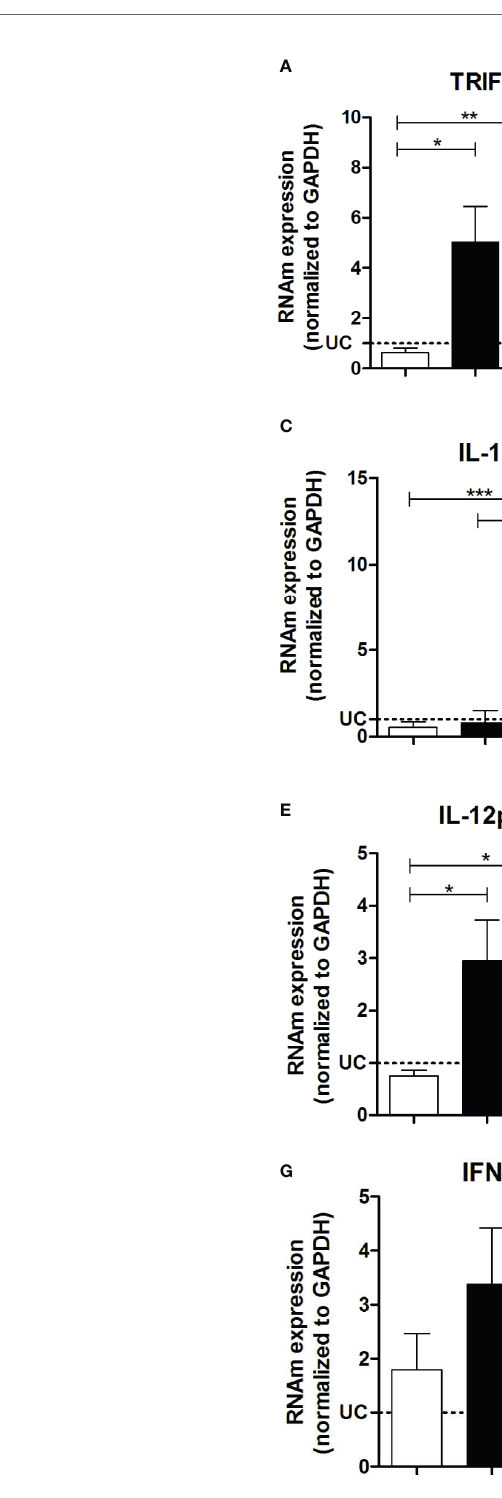
FIGURE 4 | Virulence of strains is correlated with TRIF, Myd88, IL-6, IL-12 inhibition in the heart from mice.The mRNA expression levels of TRIF (A) , Myd88 (B) , IL-10 (C) , IL-6 (D) , IL-12p35 (E) , IL-12p40 (F) , and IFN- g (G) were determined by real-time PCR in the heart from Swiss mice infected by the intraperitoneal route with 1 × 10 4 blood trypomastigote forms of T. cruzi strains that showed low (AM64 + 3253) (n = 10), medium (PL1.10.14 + CL) (n = 10), and high (Colombian + Y) (n = 10) virulence. The expression levels were normalized to the expression level of GAPDH. The results are expressed as the means ± standard errors. * p < 0.05; ** p < 0.01; *** p < 0.001. UC, uninfected control mice (n =